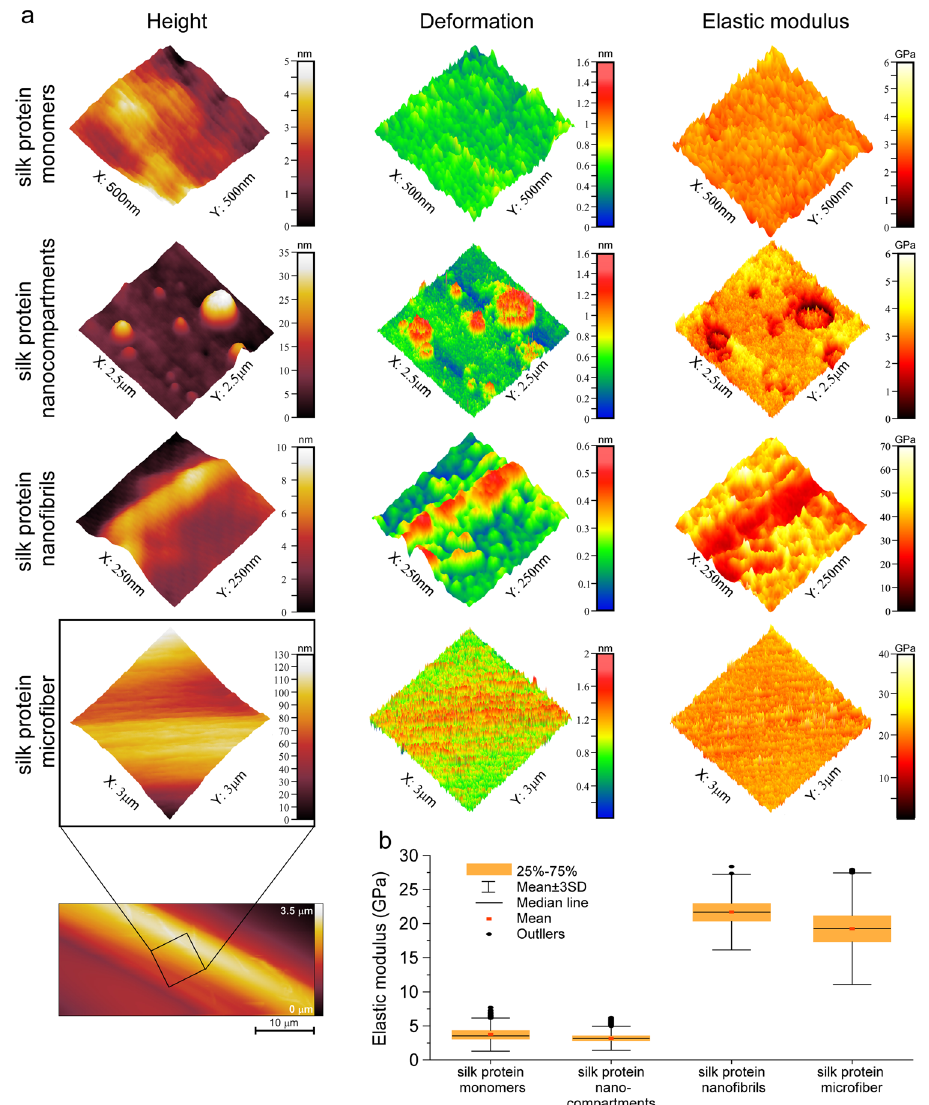
Fig.5|Nanomechanicalanalysisofsilk fi broinassemblystates.a Comparisonof the height, deformation and elastic modulus of silk protein monomers, compart- ments, nano fi brils and micro fi bers. b Quantitative analysis of the elastic modulus